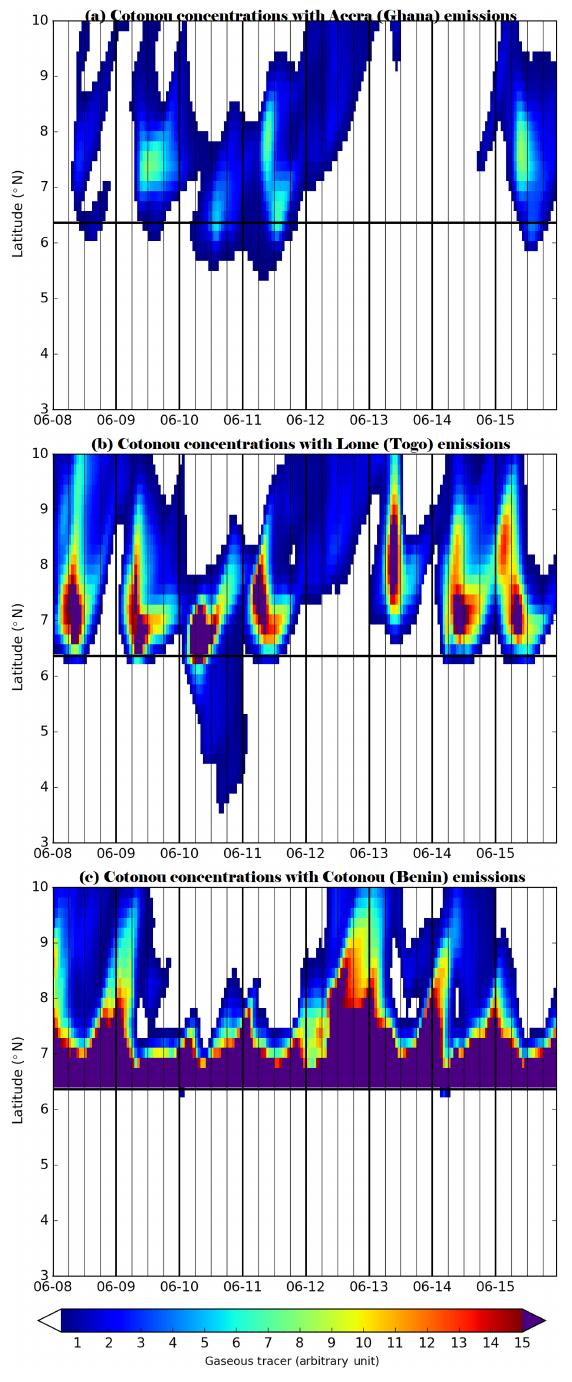
Figure 10. Time–latitude average (Hovmöller) of gaseous tracer concentration (a.u.) averaged along a meridional transect between 2 and 3 ◦ E centered on Cotonou (Benin) from 8 to 15 June 2006. Emissions are set up with a constant emission between 0 and 500m altitude at (a) Cotonou (Benin), (b) Lome (Togo) and (c) Accra (Ghana). Black vertical bars delimit the periods of the day (00:00, 06:00, 12:00,